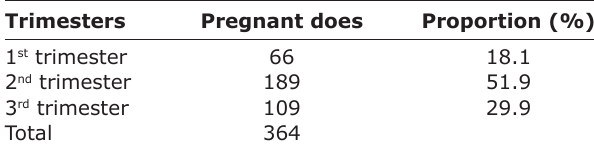
Table-4: Pregnancy status of the female goats slaughtered.